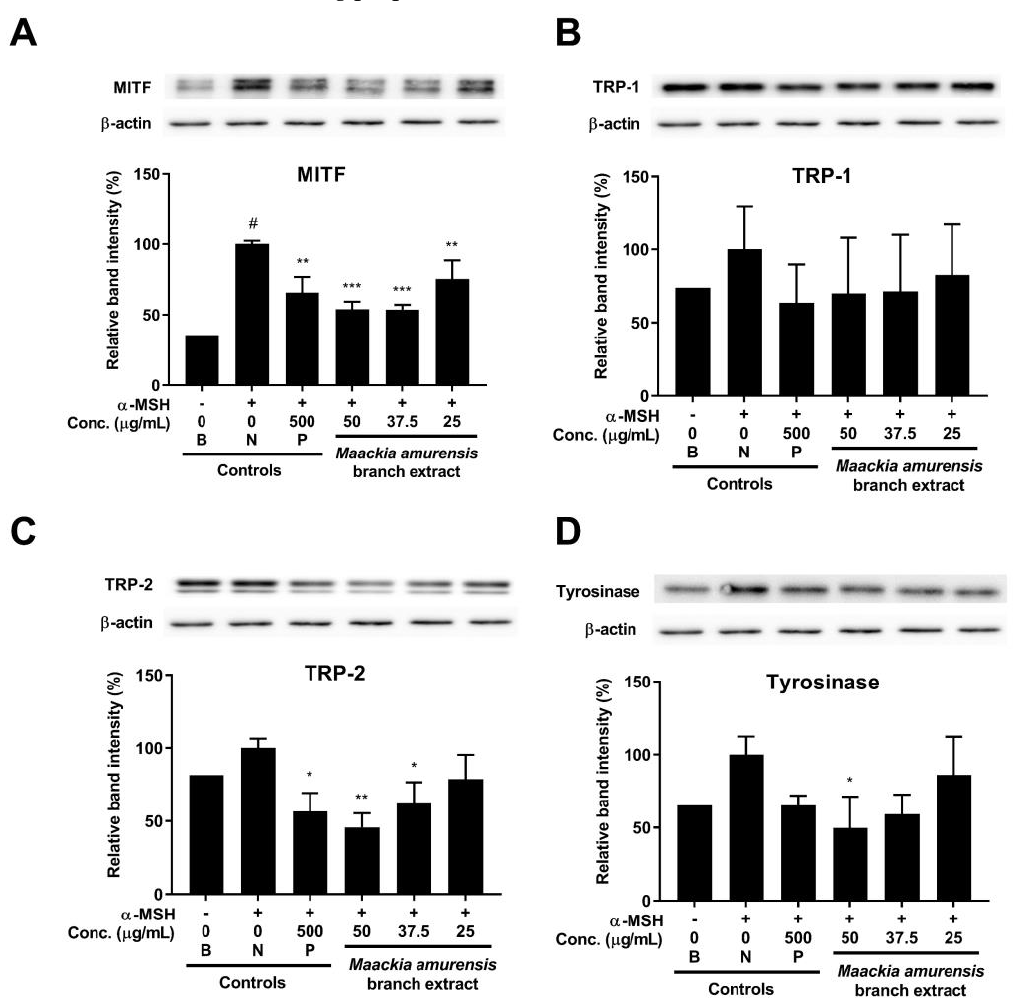
Figure 3. Effect of Maackia amurensis branch extract on α -MSH-induced melanogenic protein expres- sion in B16F1 melanoma cells. B16F1 cells were treated with arbutin or various concentrations (50, 37.5, and 25 μg/mL) of M. amurensis branch extract for 72 h in the presence or absence of 0.2 μM α - MSH. After treatment, western blotting analysis of microphthalmia-associated transcription factor (MITF), tyrosinase, tyrosinase-related protein (TRP)-1, and TRP-2 was performed. M. amurensis branch extract significantly inhibited the α -MSH-induced expression of (A) MITF, (C) TRP-2, and (D) tyrosinase. (B) M. amurensis branch extract inhibited TRP-1 expression, albeit not significantly. Data are presented as mean ± SD of three independent experiments. # p < 0.05 between blank and NC groups. * p -value between NC and M. amurensis branch extract groups (* p < 0.05, ** p < 0.01, and *** p < 0.001). B, blank; N, negative control; P, positive control (arbutin).